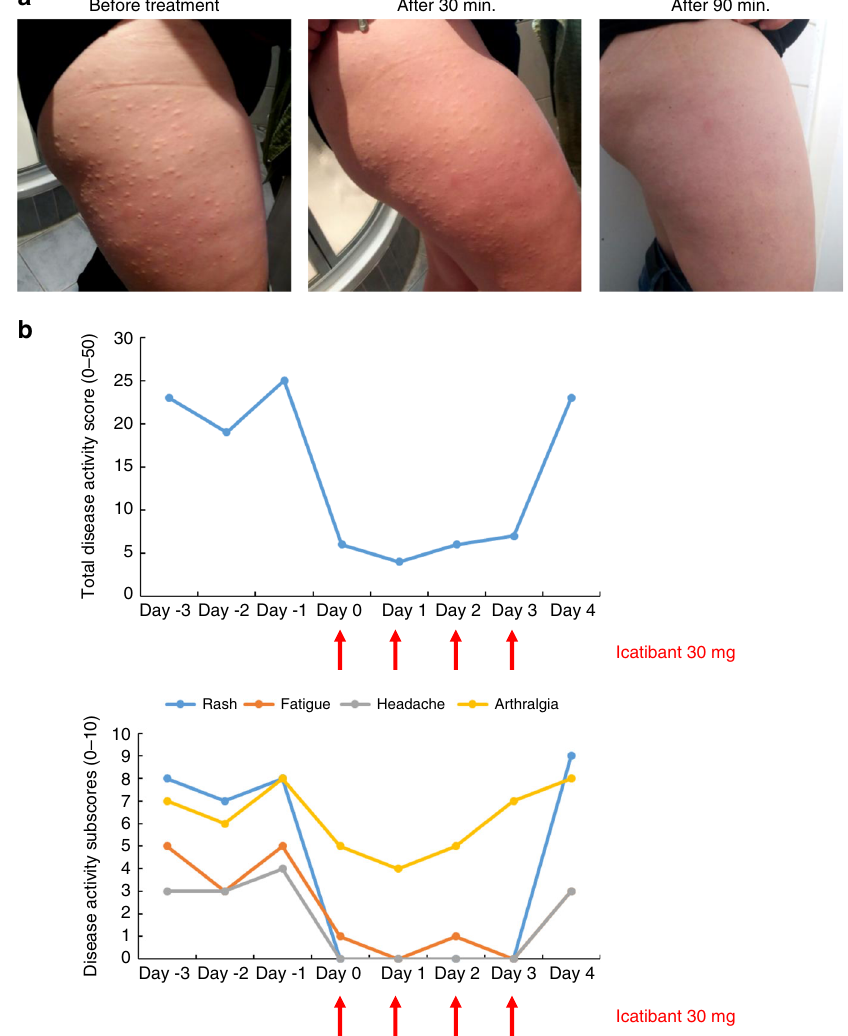
Fig. 6 The bradykinin B2 receptor antagonist icatibant resolves FACAS signs and symptoms. During winter with continuous skin symptoms, the index patient administered icatibant 30 mg. a Urticarial rash completely resolved within 90 min post icatibant application (from the left to right). b Total and individual symptoms reported and assessed daily over a time period of 8 days by the patient using a standardized daily health assessment form covering the main symptoms rash, fatigue, headache, arthralgia, and fever/chills. The total score ranges from 0 = no symptoms to 50 = maximum of symptoms. Each subscore can range from 0 = no symptoms to 10 = maximum of symptoms. The subscores do not show fever/chills as these symptoms were not present at that time. Icatibant was given on 4 consecutive days (red